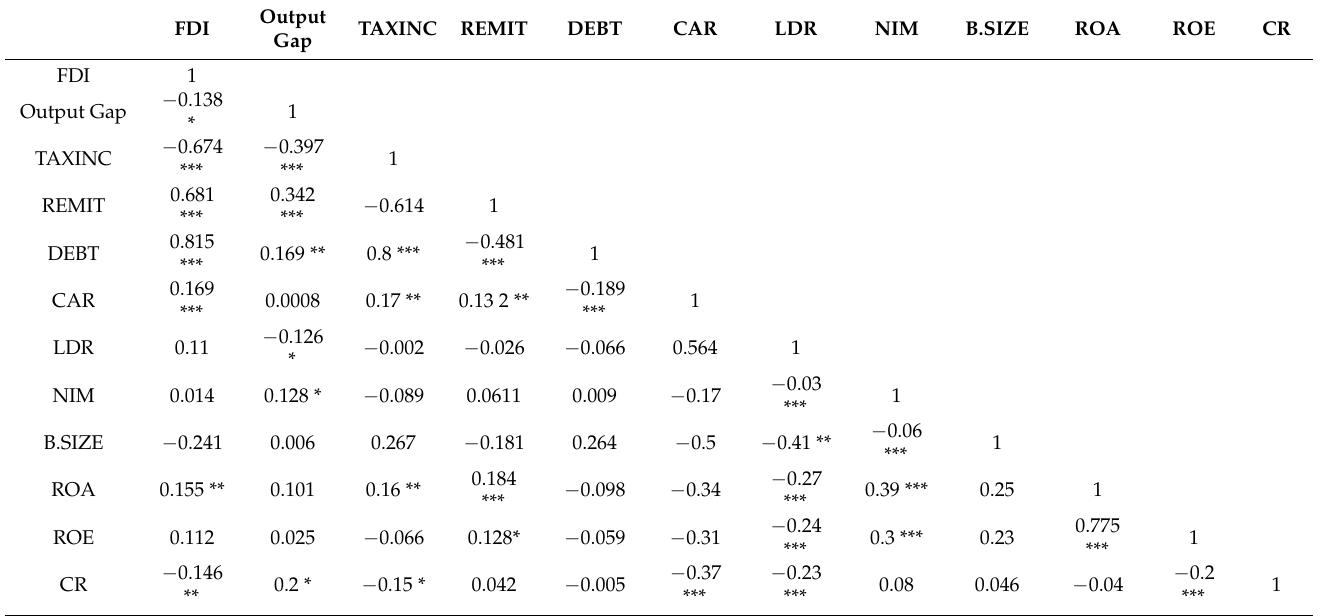
Table 4. Pearson’s correlation